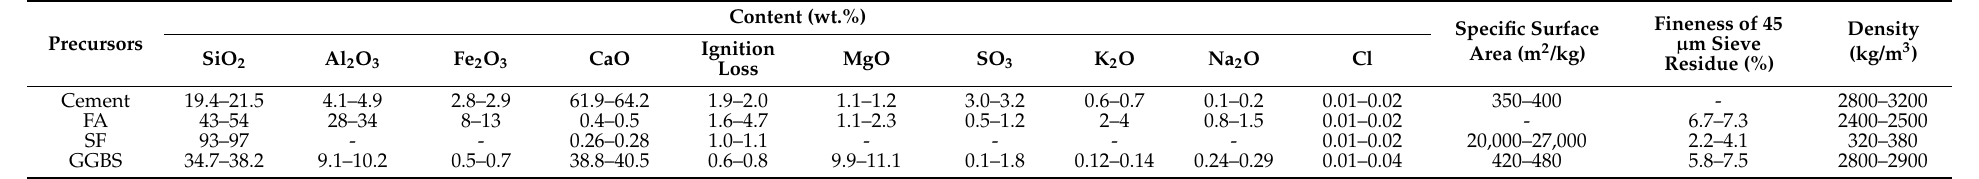
Table 1. Chemical compositions, specific surface area, fineness of 45 µ m sieve residue, and density of the cement, FA, SF, and GGBS